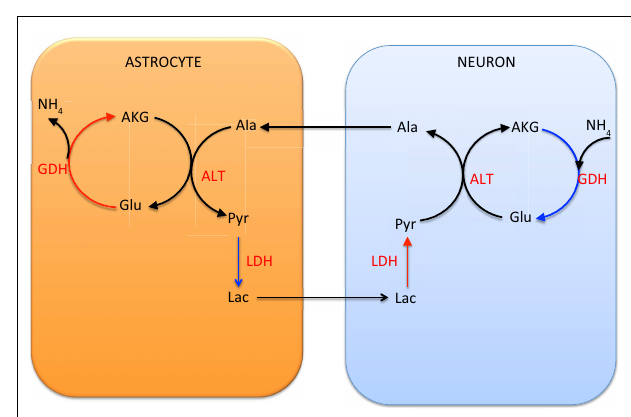
FIGURE 2 |The lactate-alanine cycle between astrocyte and neuron . Observe that in order to complete the cycle, lactate needs to move from astrocyte to neuron.The shuttle is in redox equilibrium, since in both cells the oxidative (red arrows) and reductive (blue arrows) reactions compensate each other. However, in order for this shuttle to be efficient at transferring ammonium, it requires reductive activity of the GDH in the neuronal mitochondria, a scenario that has been questioned in the literature both for theoretical reasons and in the light of experimental evidence (1).